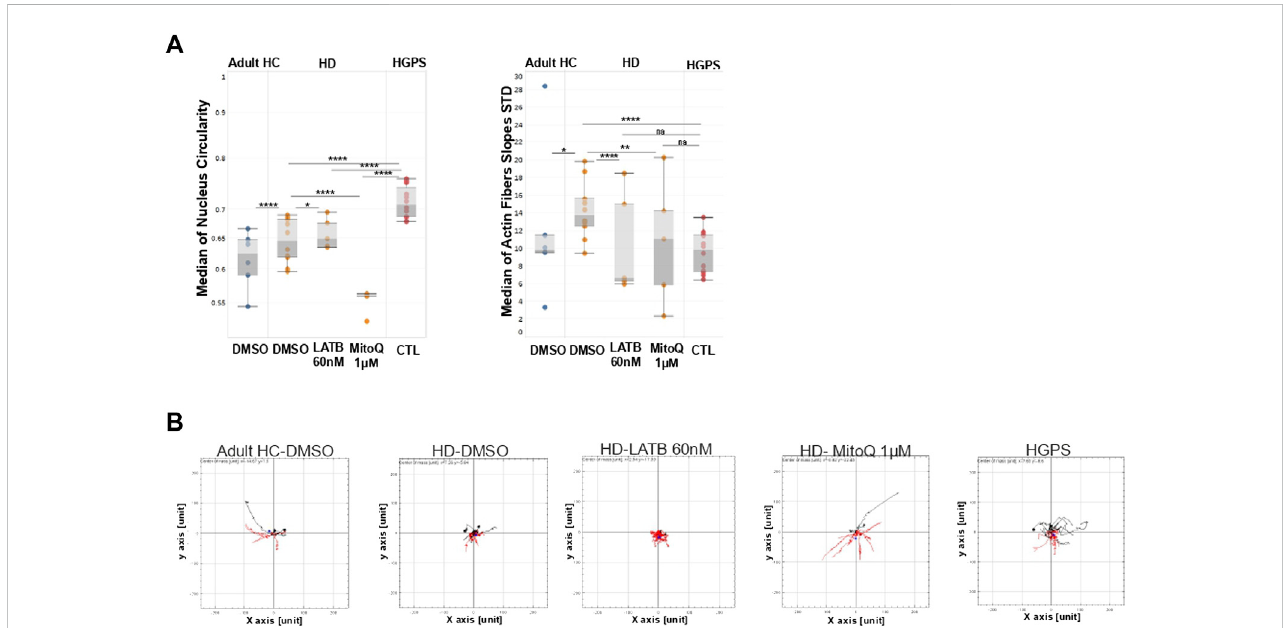
FIGURE 5 EffectofMitoQandLatrunculinBontheactincapinHDFibroblastcomparedtoHCandHGPS (A) Mann-Whitney ’ sUtestwasperformedonthemedians of different actin cap like features generated from the image analysis tool mentioned above in HC fi broblast cells compared to the HD and HGPS per fi eld (3 HC, 5 HD, 2 HGPS), ~200 cells from each skin fi broblast sample using GraphPad 8, the results are presented in box plots using Tableau 2020.3 (B) Cell tracking analysis was carried out in the same conditions mentioned in materials and methods section. Sun plots show the cell path for representative ~10 cells from each population. Graphs were generated by The Chemotaxis and Migration Tool (ImageJ